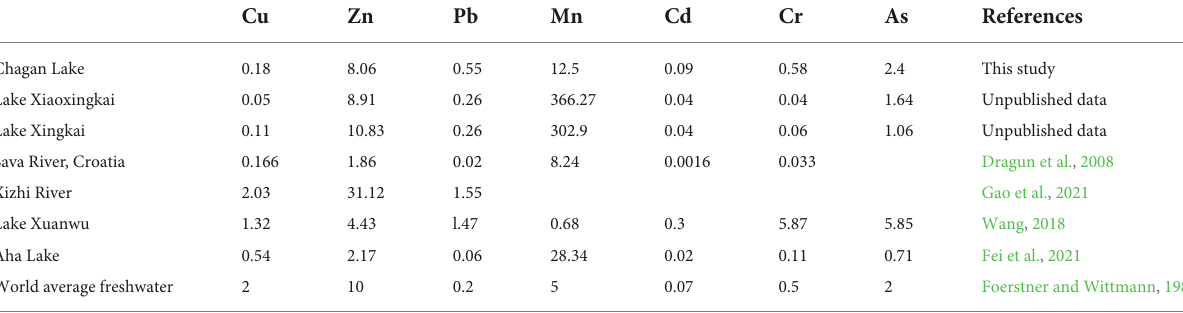
TABLE 3 The Cdgt of labile metals ( µ g/L) in Chagan Lake and other